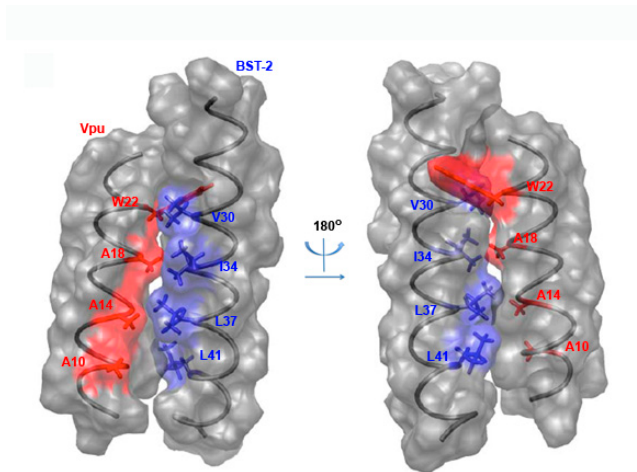
Figure 4. Structural interface between Vpu and BST-2. The Vpu and BST-2 transmembrane helices are shown in an antiparallel orientation. On the Vpu-side, the interface consists of an alanine-face (A10-A14-A18) followed by a membrane-anchoring tryptophan (W22), which likely inserts its side chain among the lipid head groups on the cytoplasmic side of the bilayer. On the BST-2-side, hydrophobic residues (L41-L37-I34) project their side chains toward the alanine-face of Vpu.